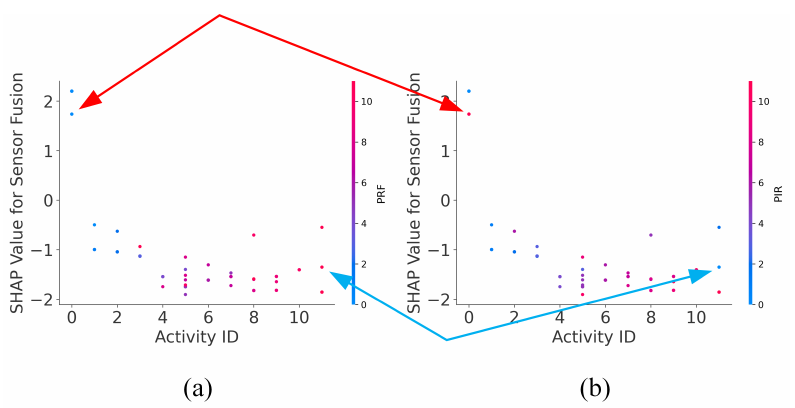
Figure 8. Interaction dependence plot of ( a ) PRF-PIR with PRF and ( b ) PRF-PIR with